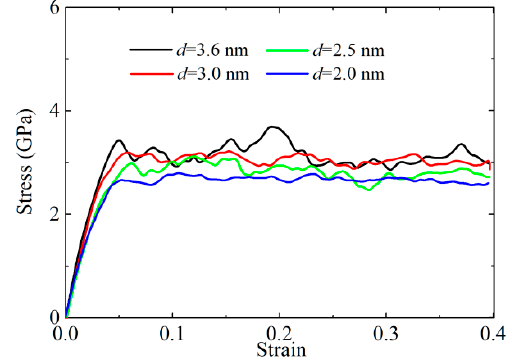
Figure 3. The stress-strain curve of CoCrFeNiMn with different mean grain sizes at 300 K.